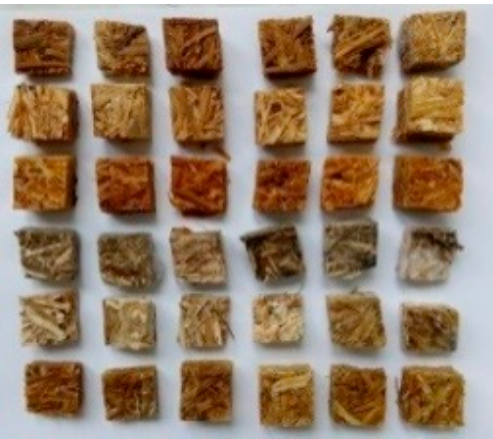
Figure 2. The photo of the samples covered by molds after finishing of the test (from top to bottom): glue sample, glue-H 2 O sample, glue-NaOH sample, epoxy sample, epoxy-H 2 O sample, epoxy-NaOH sample. The first three samples (from top to bottom) were sterile and the other three samples were nonsterile in each line. All samples contained straw.